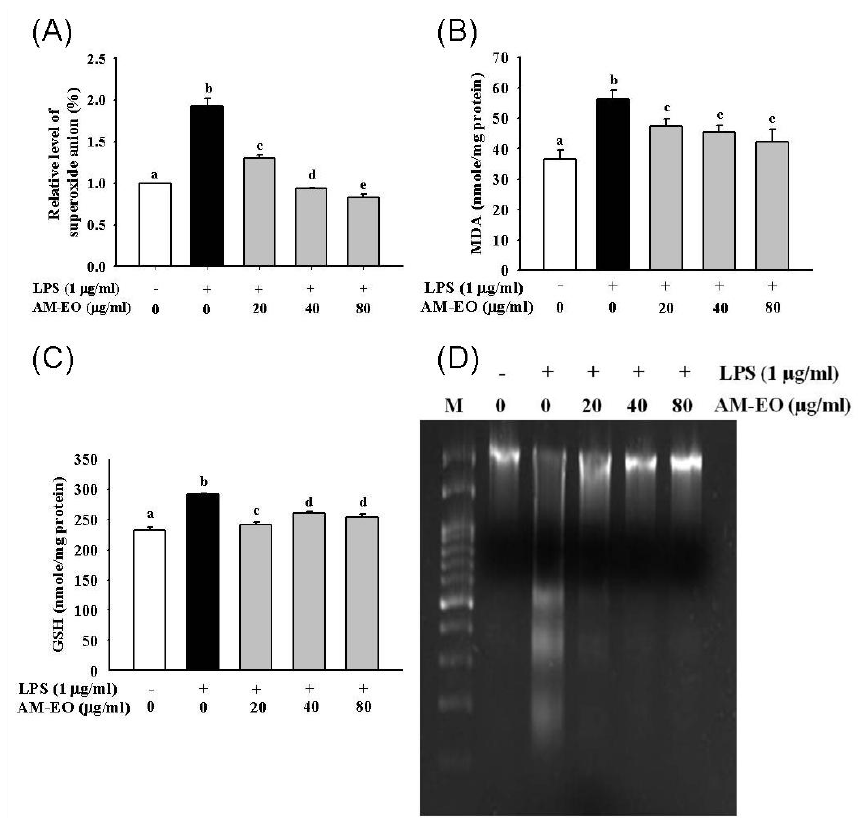
Figure 3. The effect of AM-EO on ( A ) superoxide anion, ( B ) malondialdehyde (MDA) production, ( C ) glutathione (GSH) concentration and ( D ) DNA damage by